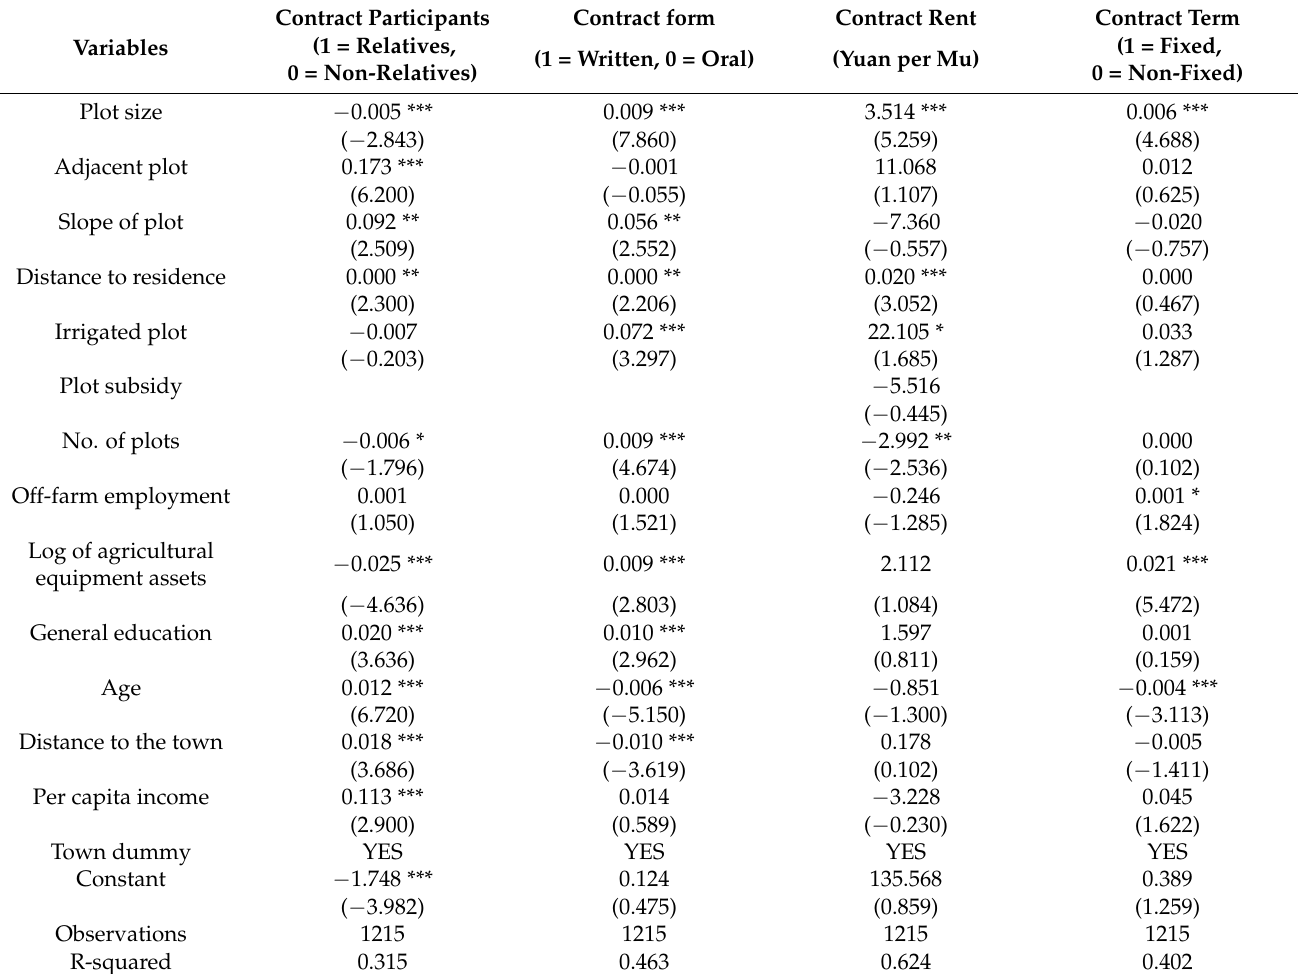
Table 5. The impact of the characteristics of rented-in plots on contract choice, SUR